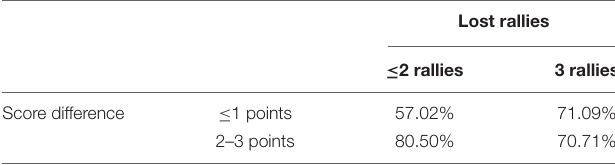
TABLE 4 | Probability of a positive timeout effect in balanced sets.